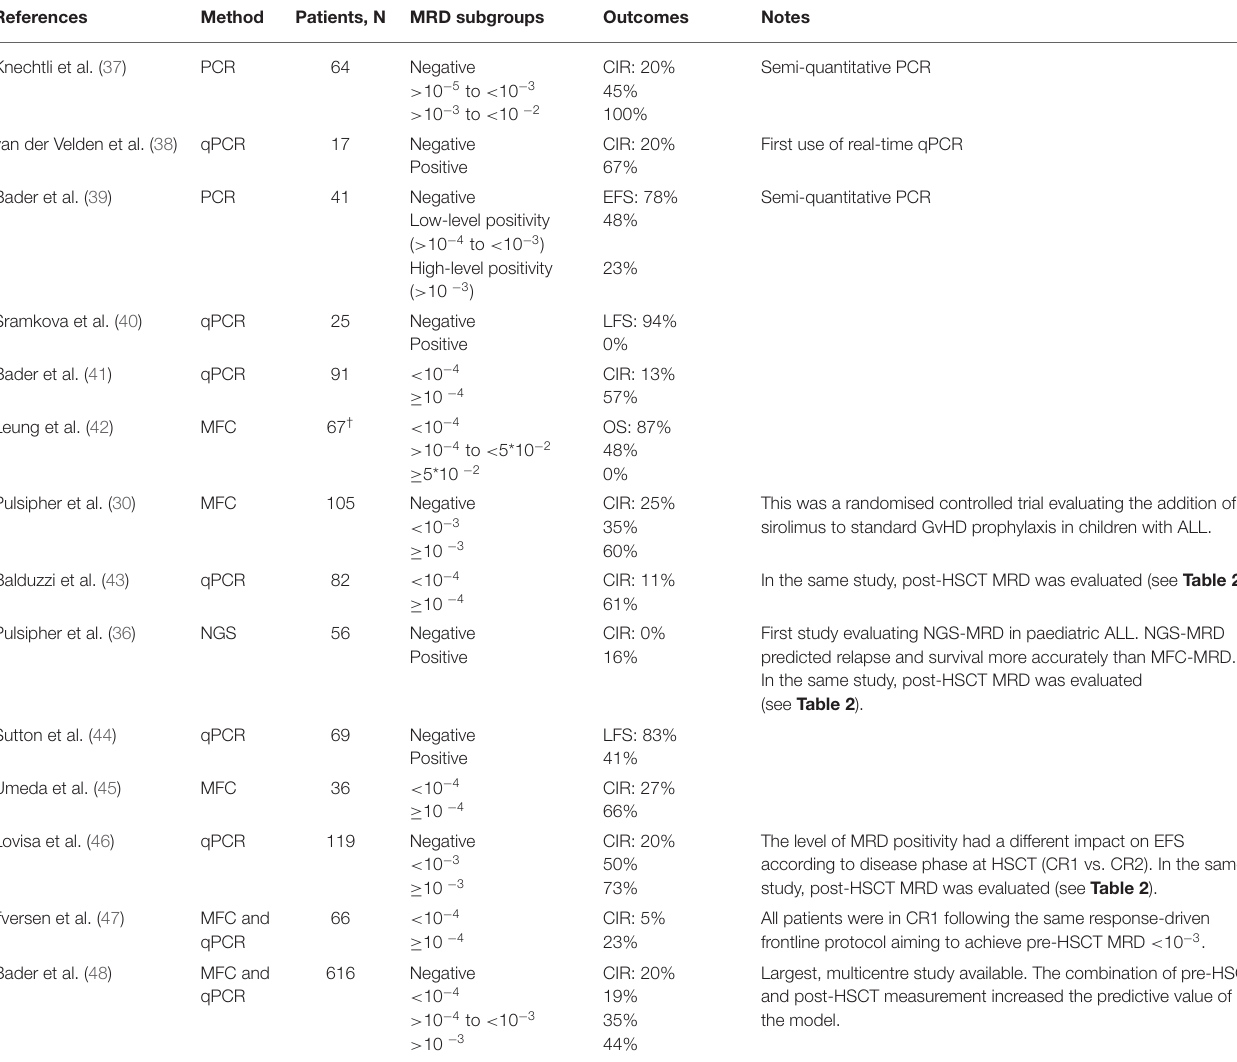
TABLE 1 | Studies of MRD measurement prior to